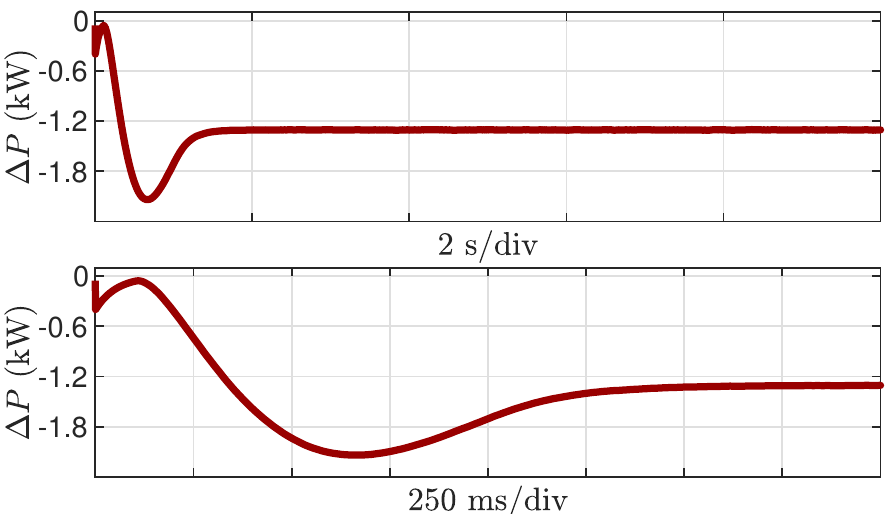
Figure 17. Test Case II: NLC ∆ P value obtained with “virtual V 2